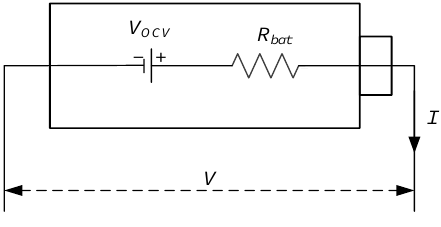
Figure 1. Battery degradation